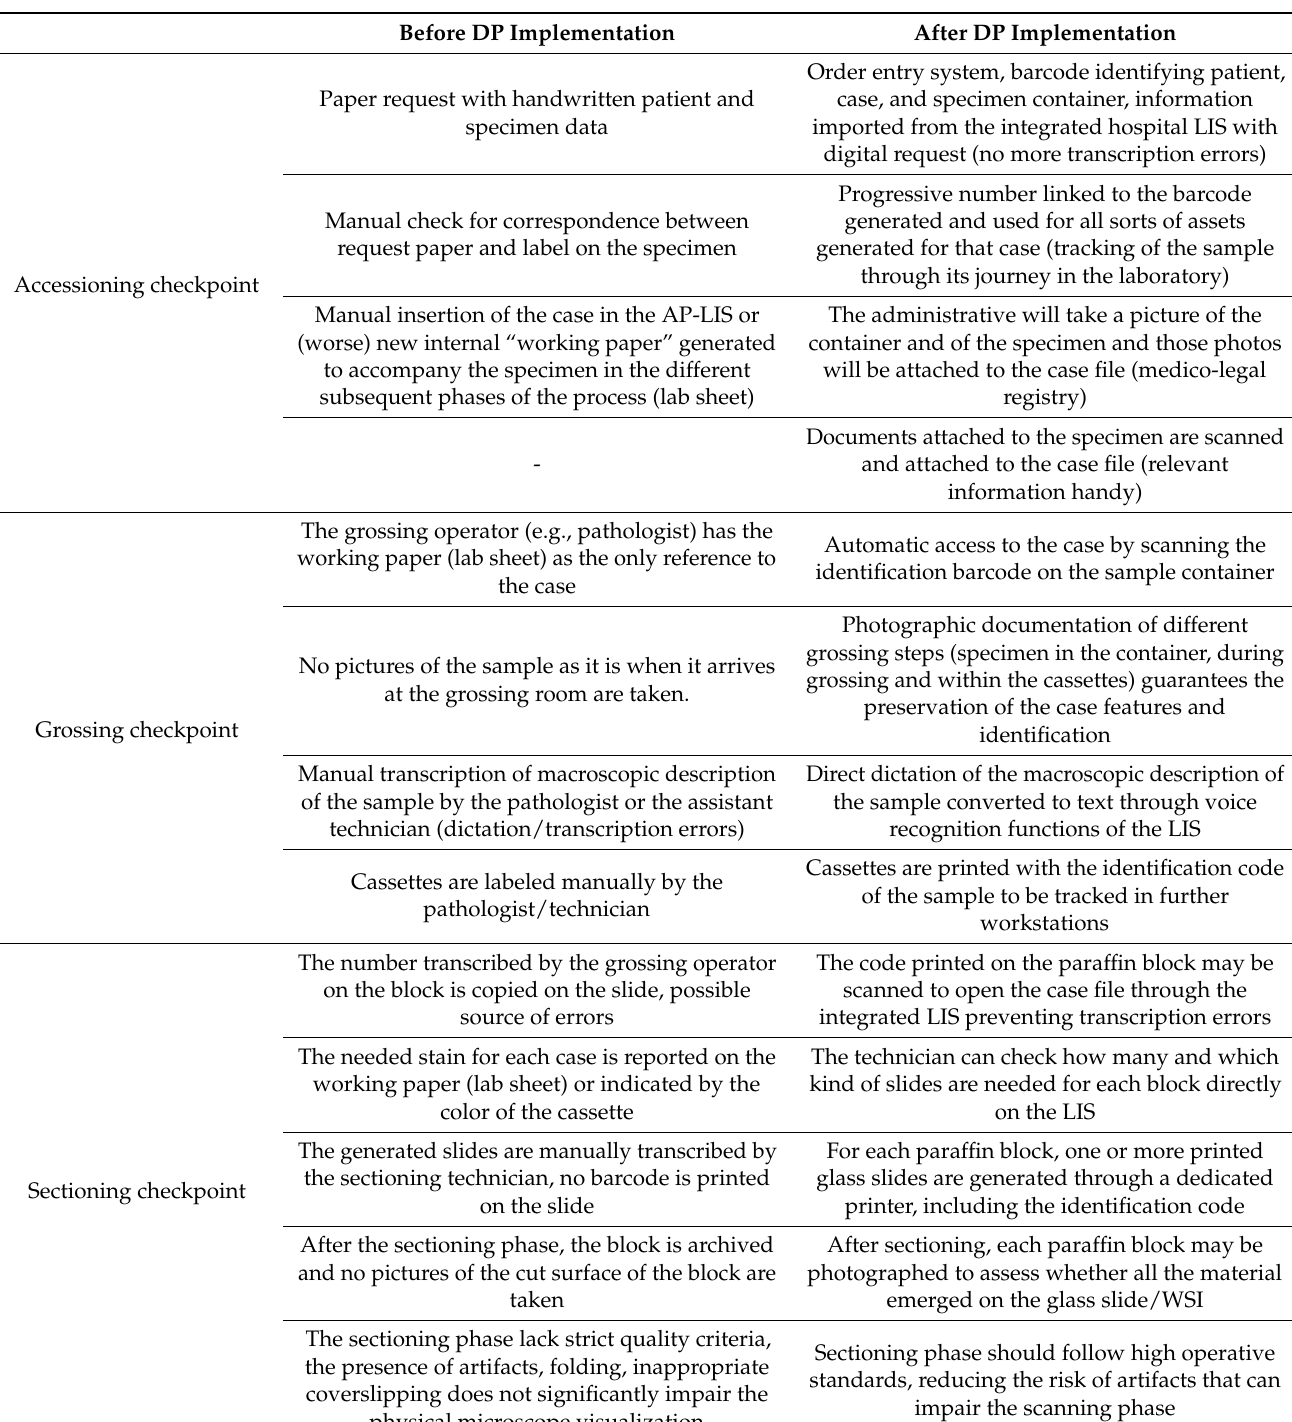
Table 4. Different steps of specimen processing as they are performed before and after the implementation of digital pathology in the laboratory. DP, digital pathology; LIS, laboratory information system; WSI, whole slide